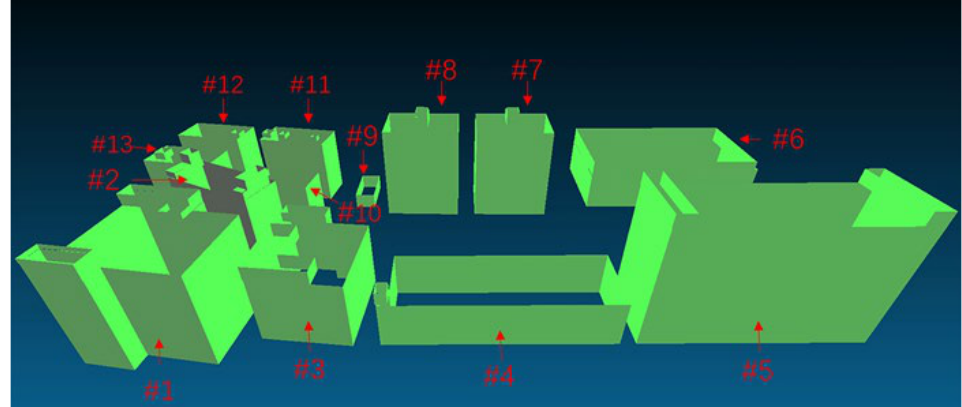
Figure 12. The façade reconstruction result.